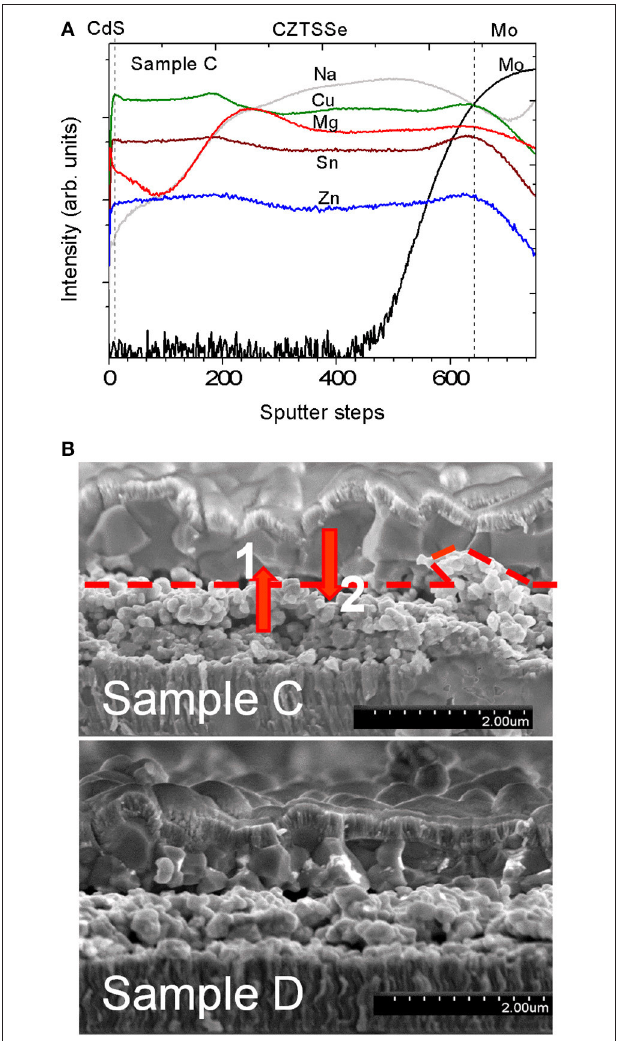
FIGURE 2 | (A) SIMS depth profile of CdS/CZTSSe/Mo corresponding to device C. (B) Cross-sectional SEM micrographs of the completed devices C and D. In the device C the positions 1 and 2 correspond to the penetration depths where Raman measurements were carried out (see Figure 3 ). A dash line indicates the border where a clear change of grain size and crystallinity of the bilayer structure occur.